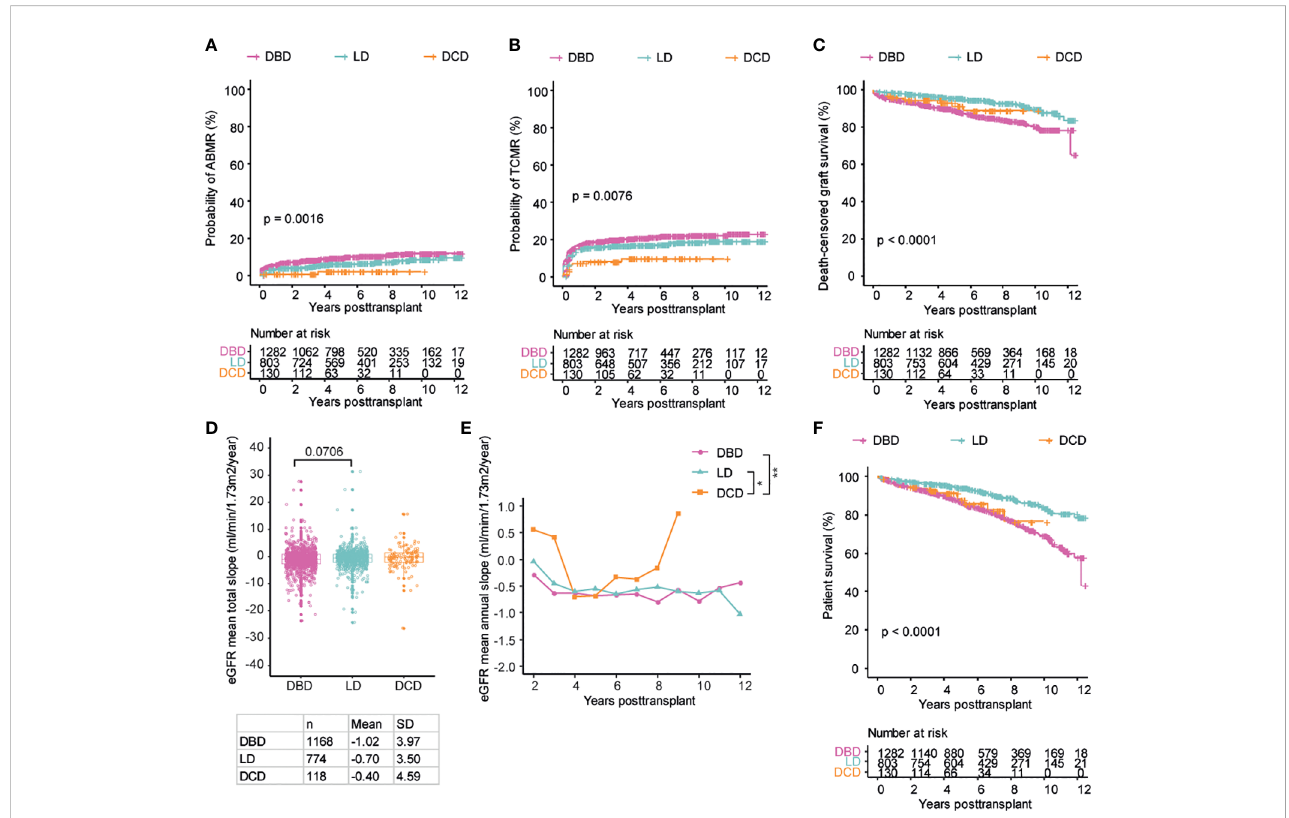
FIGURE 2 Patients receiving DCD transplants show similar outcomes as the DBD and LD patients regarding the development of ABMR, TCMR, graft survival and graft function. Cumulative incidence of ABMR (A) , TCMR (B) , death-censored graft survival (C) , the total mean slope of eGFR (D) , the collective longitudinal mean annual slope of eGFR (E) , and overall patient survival (F) in patients with the three different donation types respectively. Log-rank test was used to test p value of the Kaplan-Meier survival curves for (A – C) and (F) . One-way ANOVA analysis with Dunn ’ s post hoc test was used for (D) and two-way ANOVA analysis with Tukey ’ s multiple comparisons as a post hoc test was used for (E) to assess p values; *p<0.05,